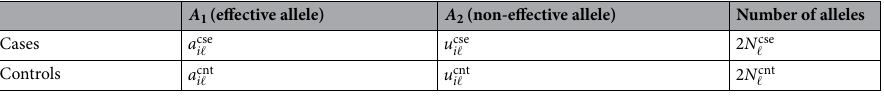
Table 8. Table of allele counts for SNP i ( i = 1 . . . M ) in the ℓ -th GWAS ( ℓ = 1 . . . L ). The total number of cse ℓ -th study is N cnt cases for the ℓ -th study is N ℓ and the total number of controls for the ℓ . Clearly, the total number of cases and controls in a study is the same for all SNPs, which is why the variable N does not depend on i . The total number of alleles in cases and controls is equal to twice the number of cases and controls, respectively.